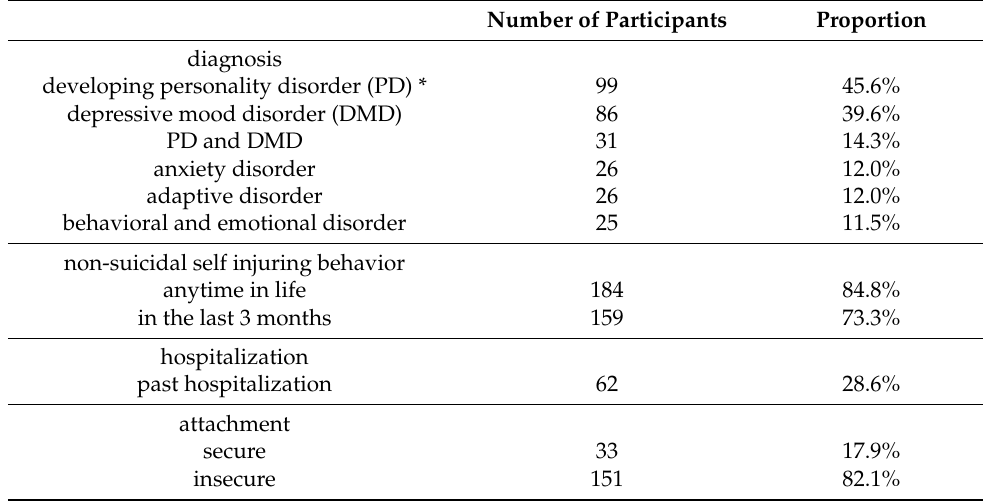
Table 2. Characteristics of the